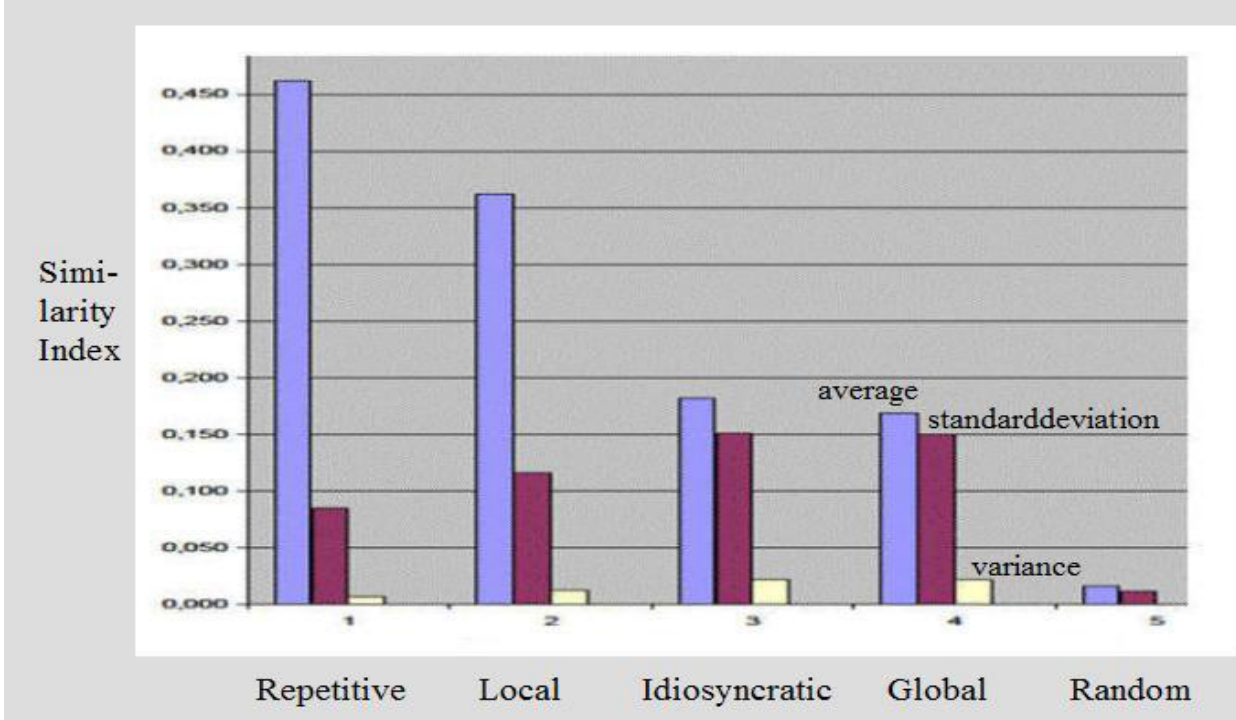
Fig.5a : Overview of picture pairs for sequential (Ss) averaged global responses of 25 pairs. For 21 pairs of paintings and snapshots subjects either did not show any viewing similarities, i.e. similarity index close to 0.11; or, they did show some higher viewing similarities between snapshots and artful pictures, such that their EM scanpaths demonstrated similarity indices that somewhat differed from random (non significantly). For four pairs of paintings and snapshots subjects did show relatively higher viewing similarities between snapshots and artful pictures, such that their EM scanpaths demonstrated similarity indices that differed clearly from random, i.e. higher than 0.1.